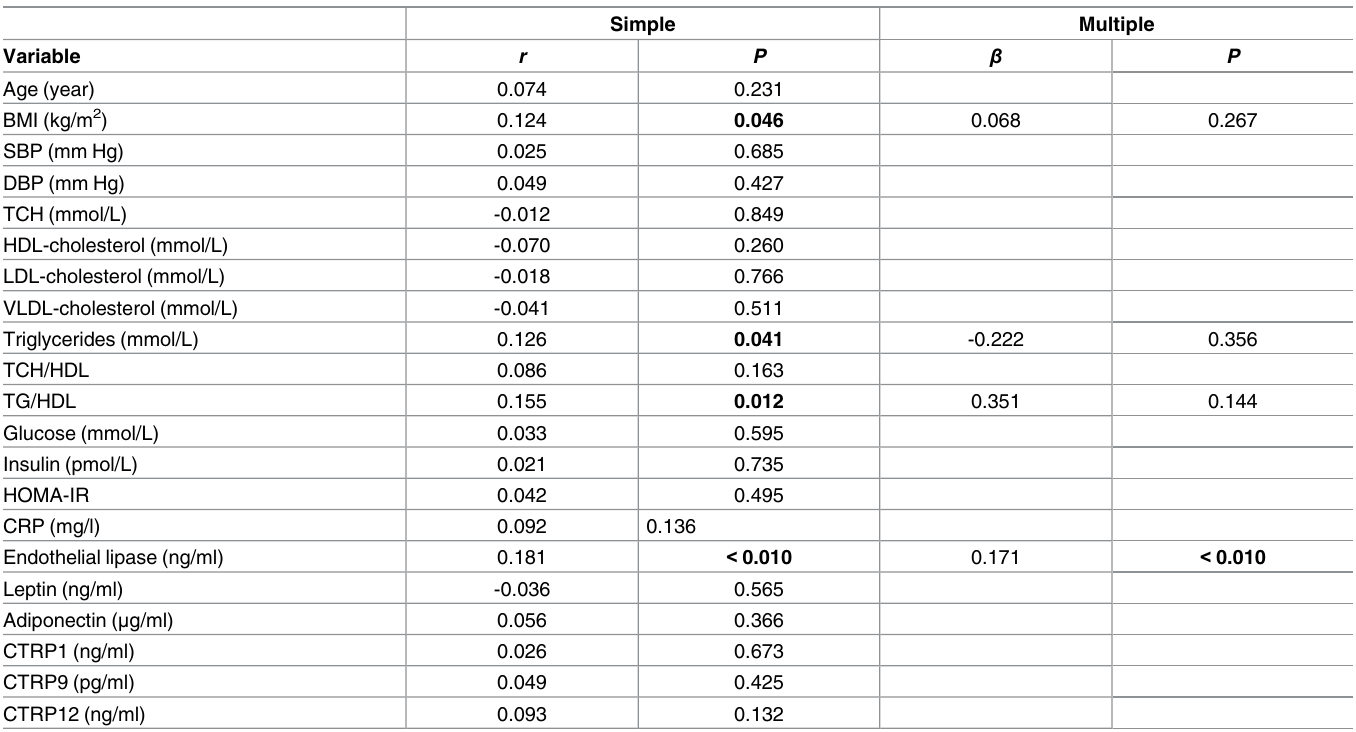
Table 6. Linear regression analysis of variables associated with CTRP13 ( n = 262).